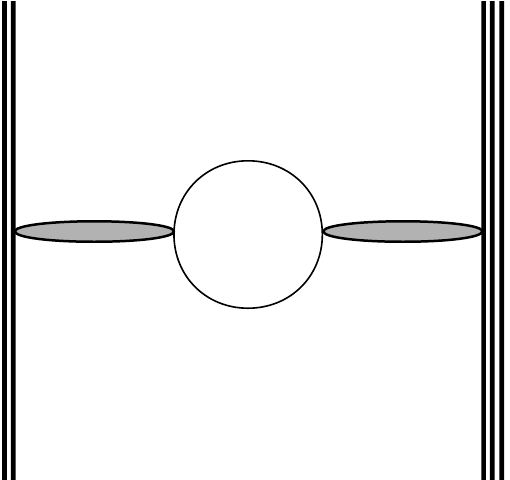
Figure 2. A quark loop exchange through two gluon bundles (shaded ovals) between two quarks of two nucleons (solid